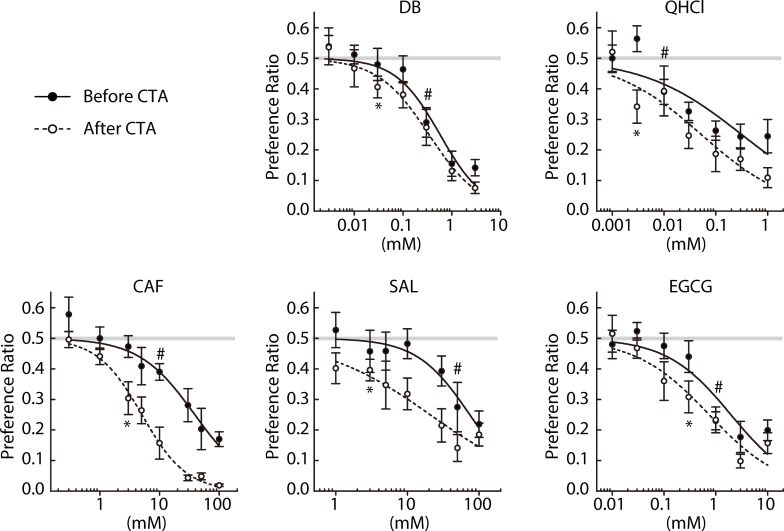
Two-bottle preference ratios for concentration series of denatonium benzoate (DB, n = 8), quinine hydrochloride (QHCl, n = 7), caffeine (CAF, n = 8), salicin (SAL, n = 8), and epigallocatechin gallate (EGCG, n = 8) measured before (closed circles) and after (open circles) poisoning with LiCl.# and * indicate the lowest concentrations at which preference ratios fell significantly (p < 0.05) below indifference (0.5) before and after CTA, respectively. Solid and dashed lines represent curves fit to the average ratios before and after CTA, respectively. Gray lines represent the indifference level (0.5).